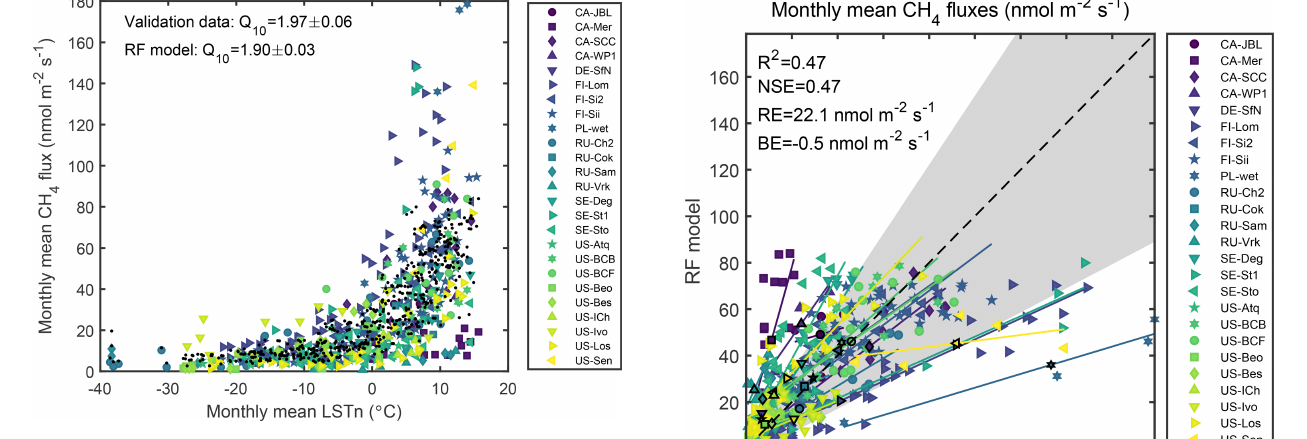
Figure 3. Dependence of monthly mean CH 4 emissions on monthly mean land surface temperature at night (LSTn) derived from MODIS data. Eddy covariance measurements are shown with filled markers (unique colour for each site) and random forest model pre- dictions for each site are given with black dots.